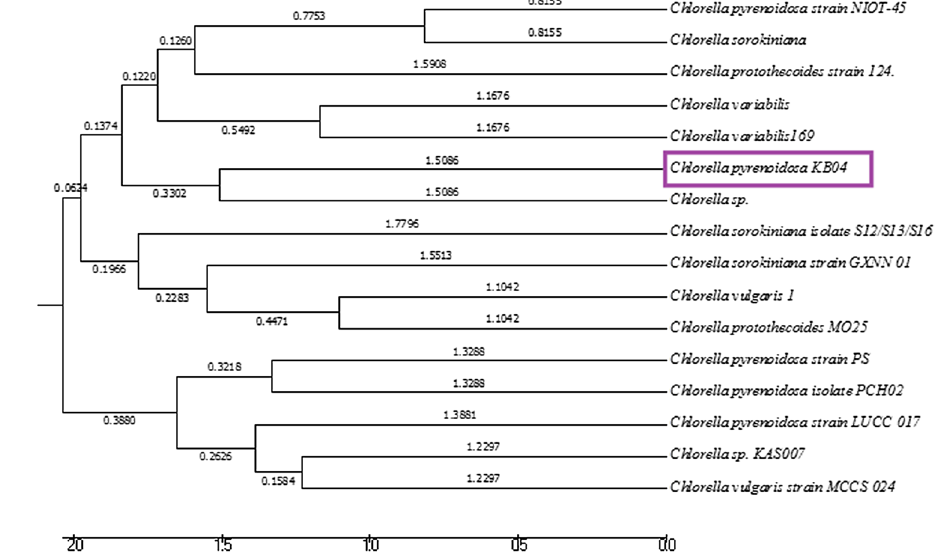
Fig. 2 Phylogenetic tree analy- sis based on 18s rRNA sequenc- ing of Chlorella pyrenoidosa showing relationship with other universal identified species